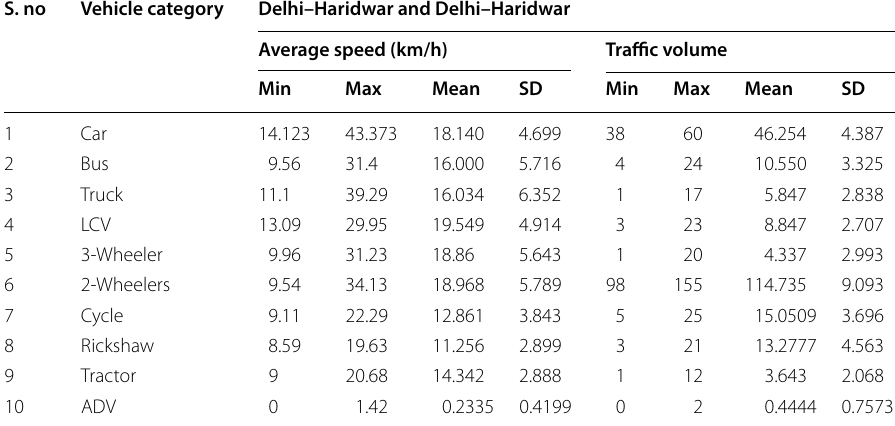
Min, minimum; Max, maximum; SD, standard deviation